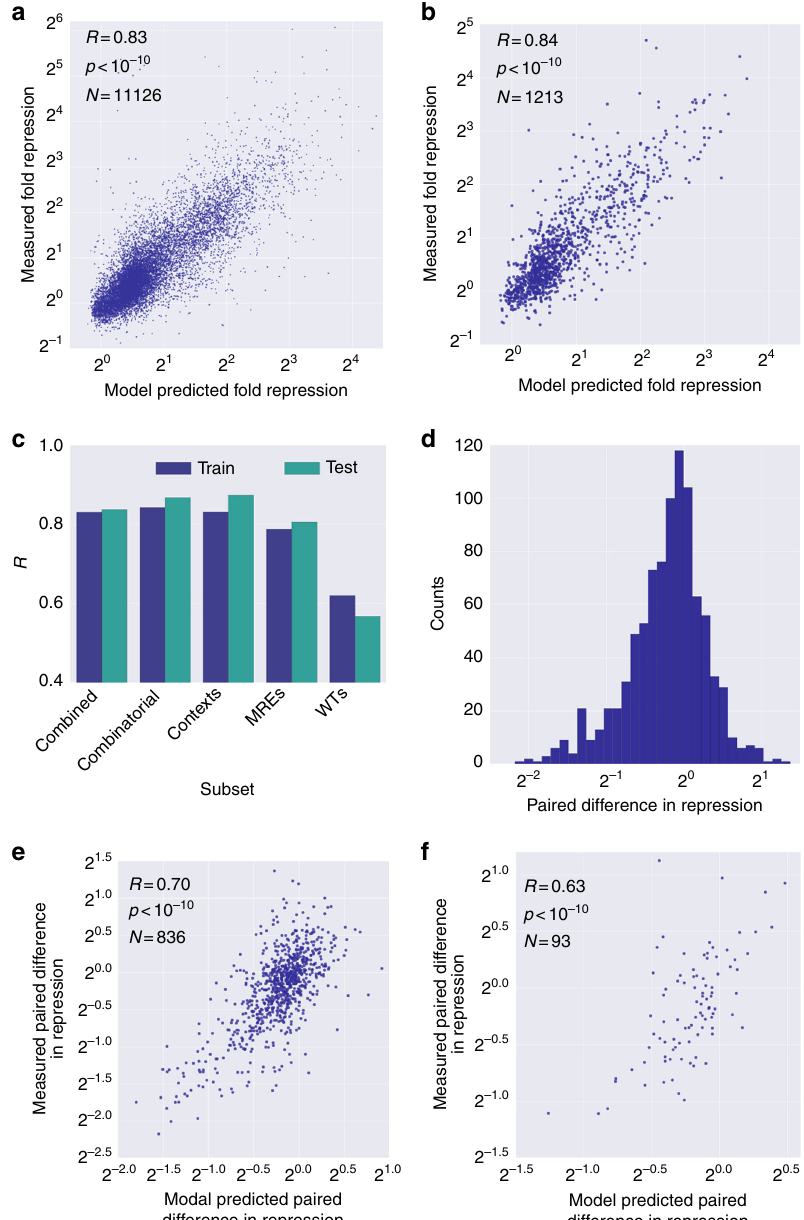
Fig. 5 Highly accurate prediction of fold repression. a Scatter plot of measured vs model-predicted fold repression on the training data. To test model performance, we applied 10-fold cross validation (Methods). b Scatter plot of measured vs model-predicted fold repression on held out data. Pearson correlation was used as the measure of model performance. c Bar plot depicting model performance on training and test data. The model performance was assessed for each mutagenesis subset as in a and b for training and test sets, respectively. d A histogram depicting the distribution of paired difference in fold repression between a WT and mutant MRE. The data contain 929 WT and mutant pairs spanning 472 unique WT sequences. For each pair, the difference in fold repression was calculated by subtracting the fold repression of the WT from the fold repression of the mutant. Only 75 pairs spanning 45 WT sequences (~8%) show a difference greater than two-fold. e Scatter plot of measured vs model-predicted paired difference in fold repression on training data. The paired difference data were divided into training and test sets (10% of the data) and the MRE-based features for the WT and the mutant were concatenated resulting in 548 input features. We applied the same 10-fold cross validation approach as in a to generate model-predicted values and plotted them against the measured values. f Scatter plot of measured vs model-predicted paired difference in fold repression on held out data. We applied the same approach as in b to generate the predicted values and plotted them against the measured